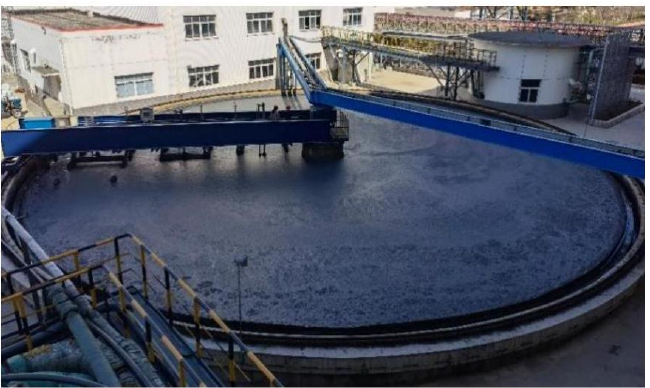
Figure 4. Layout of the thickener .